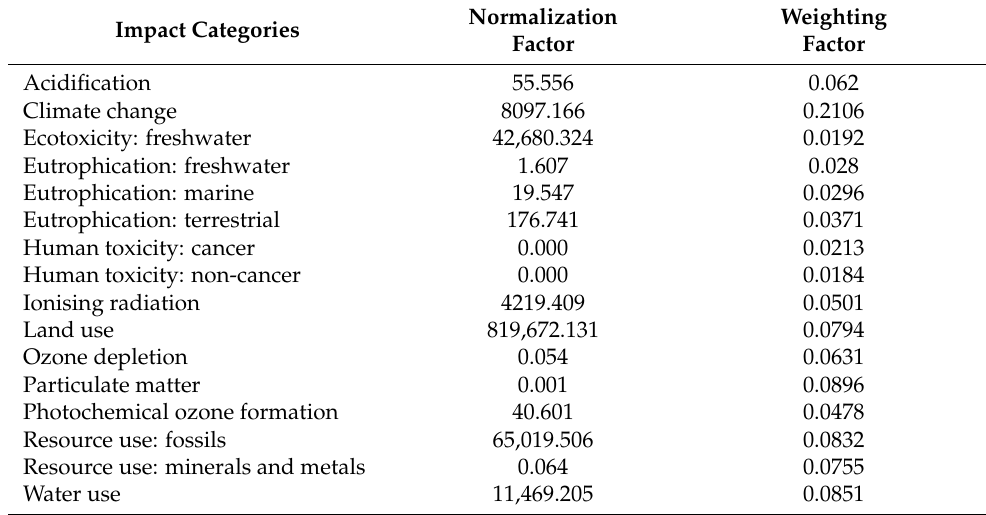
Table 2. Normalization and weighting factors for environmental impact categories using the Envi- ronmental Footprint 3.0